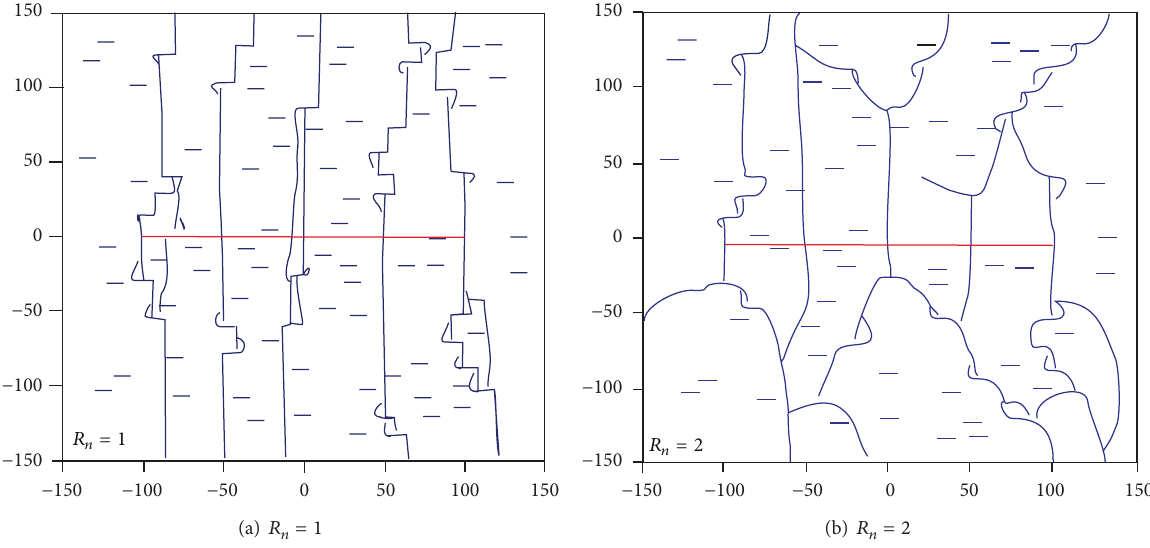
Figure 9: Hydraulic fracture propagation pattern for horizontal wells under different net pressure